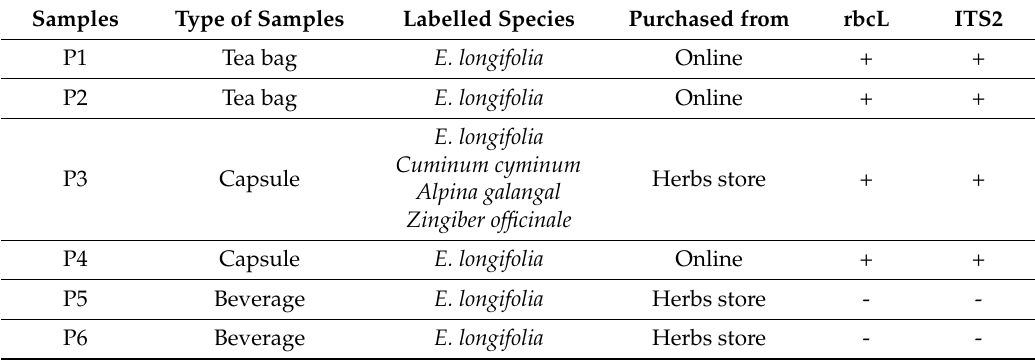
Table 1. Tested commercial Eurycoma longifolia herbal products chosen randomly from the market, abbreviated as P1–P6 (Section 2.1).